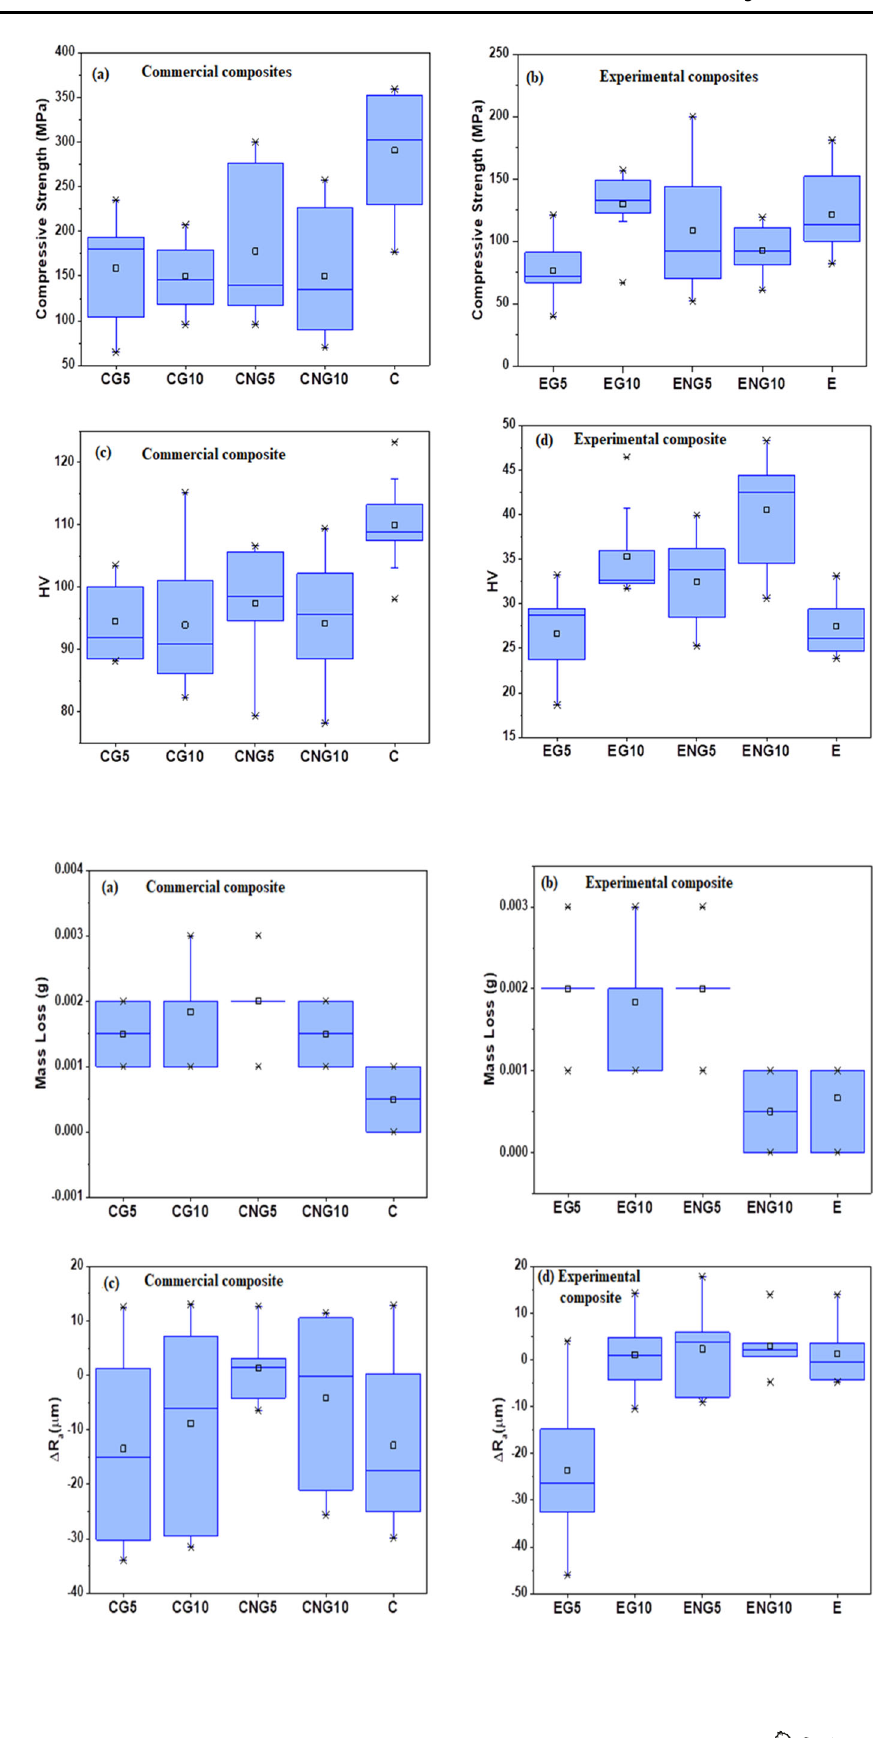
Fig. 4 Mean CS and Vickers hardness values ( a and c ) of commercial composites and ( b and d ) experimental novel composites, respectively